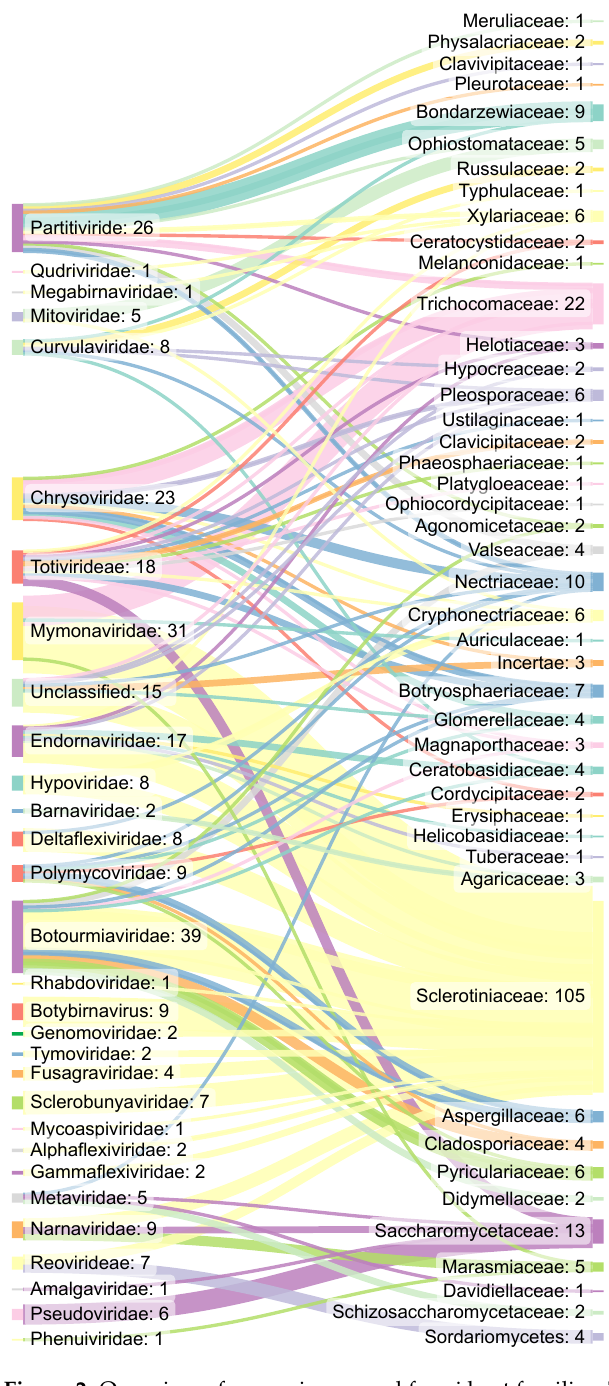
Figure 2. Overview of mycoviruses and fungi host families. The left column represents families of viruses that have been described as infecting fungi while the right column indicates fungal families affected by these mycoviruses. The information flow is represented by the thickness of the lines connecting the